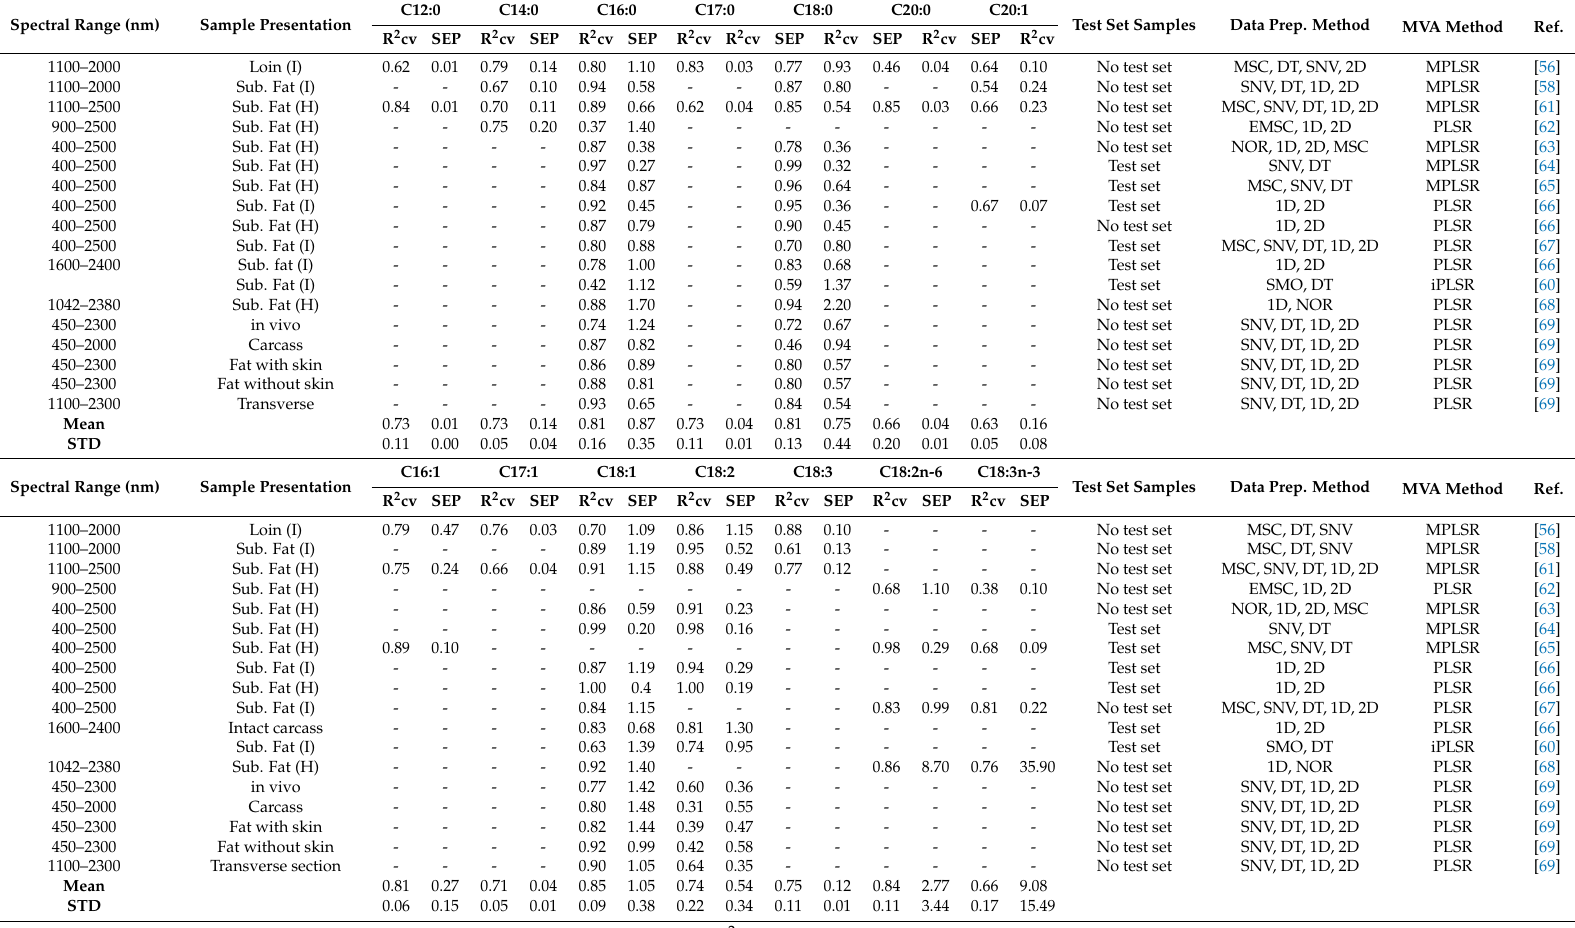
Table 2. Prediction of individual FAs in pork by Near infrared